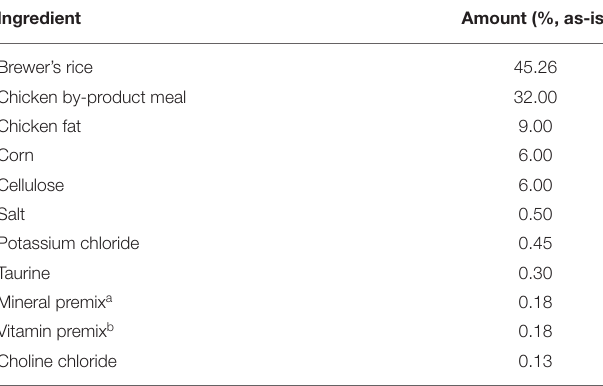
TABLE 1 | Ingredient composition of the experimental diet fed to yeast- or cellulose-supplemented dogs. Ingredient Amount (%,